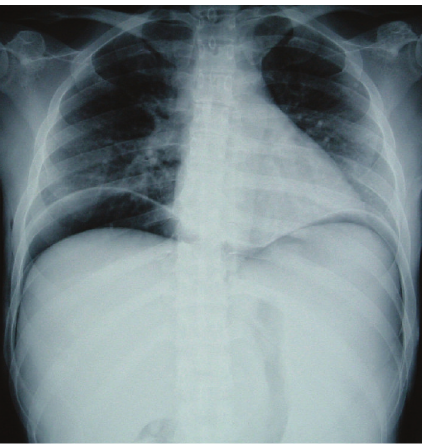
Figure 1: Chest radiograph at the initial diagnosis showed bilateral hypodiaphragmatic free air.